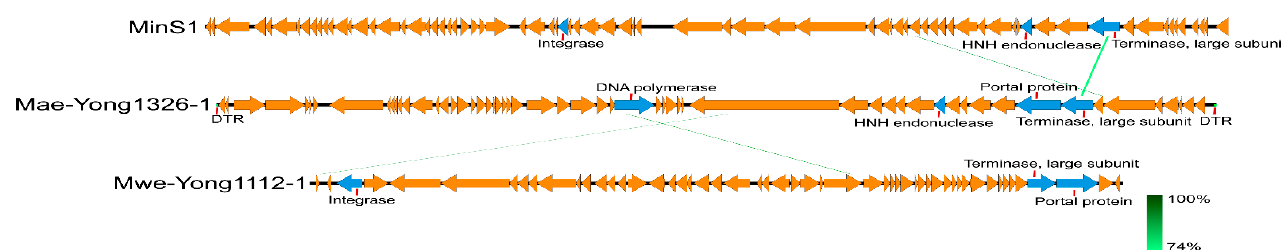
Figure 5. Phylogenetic proteomic tree of Mae-Yong1326-1, 9 reported Microcystis cyanophages, and 91 classified phages of the 33 families.